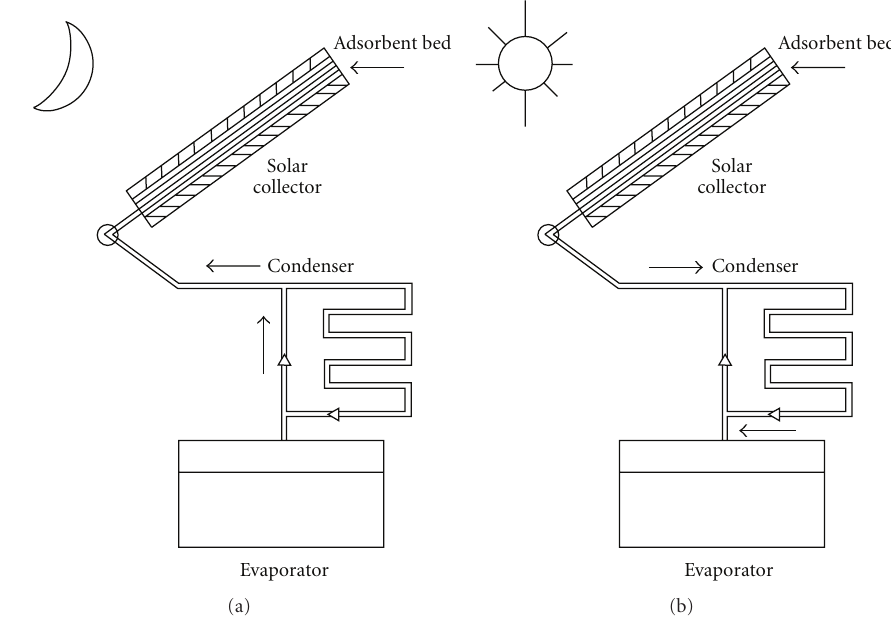
Figure 1: Scheme of adsorption solar refrigerator [8].